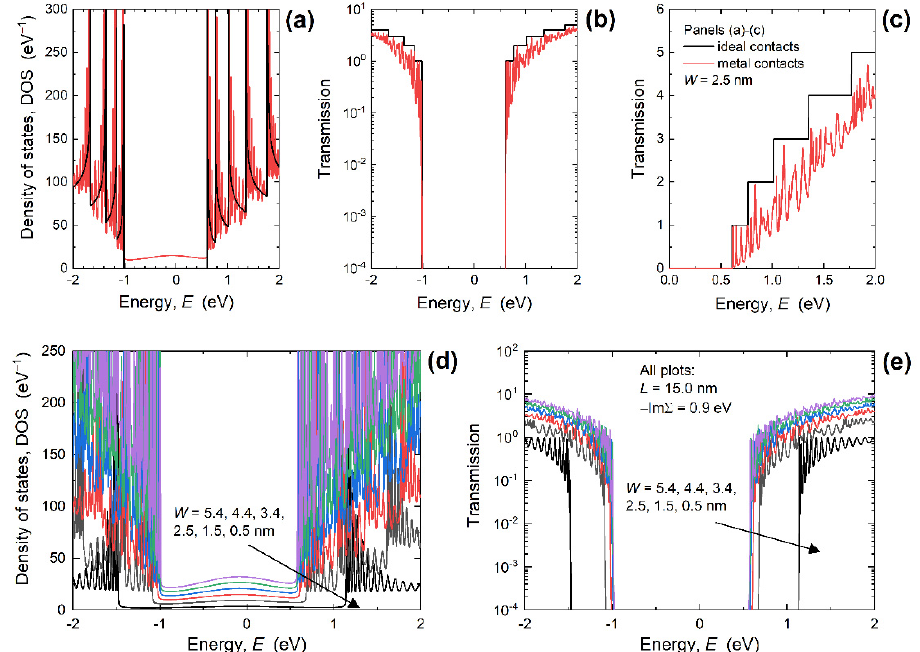
Figure 2. ( a ) DOS in linear, and transmission in ( b ) logarithmic and ( c ) linear scale for 15 nm-long and 2.5 nm-wide PNRs with ideal and metal edge contacts. Impact of width scaling on ( d ) DOS and ( e ) transmission in 15 nm-long PNRs with MECs. For all MEC-PNRs, − Im Σ R = 0.9 eV.